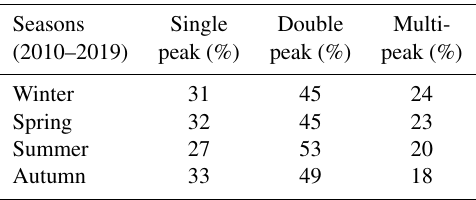
Table 5. Number of occurrences of single-peaked, double-peaked, and multi-peaked spectra at Cesenatico location for different sea- sons